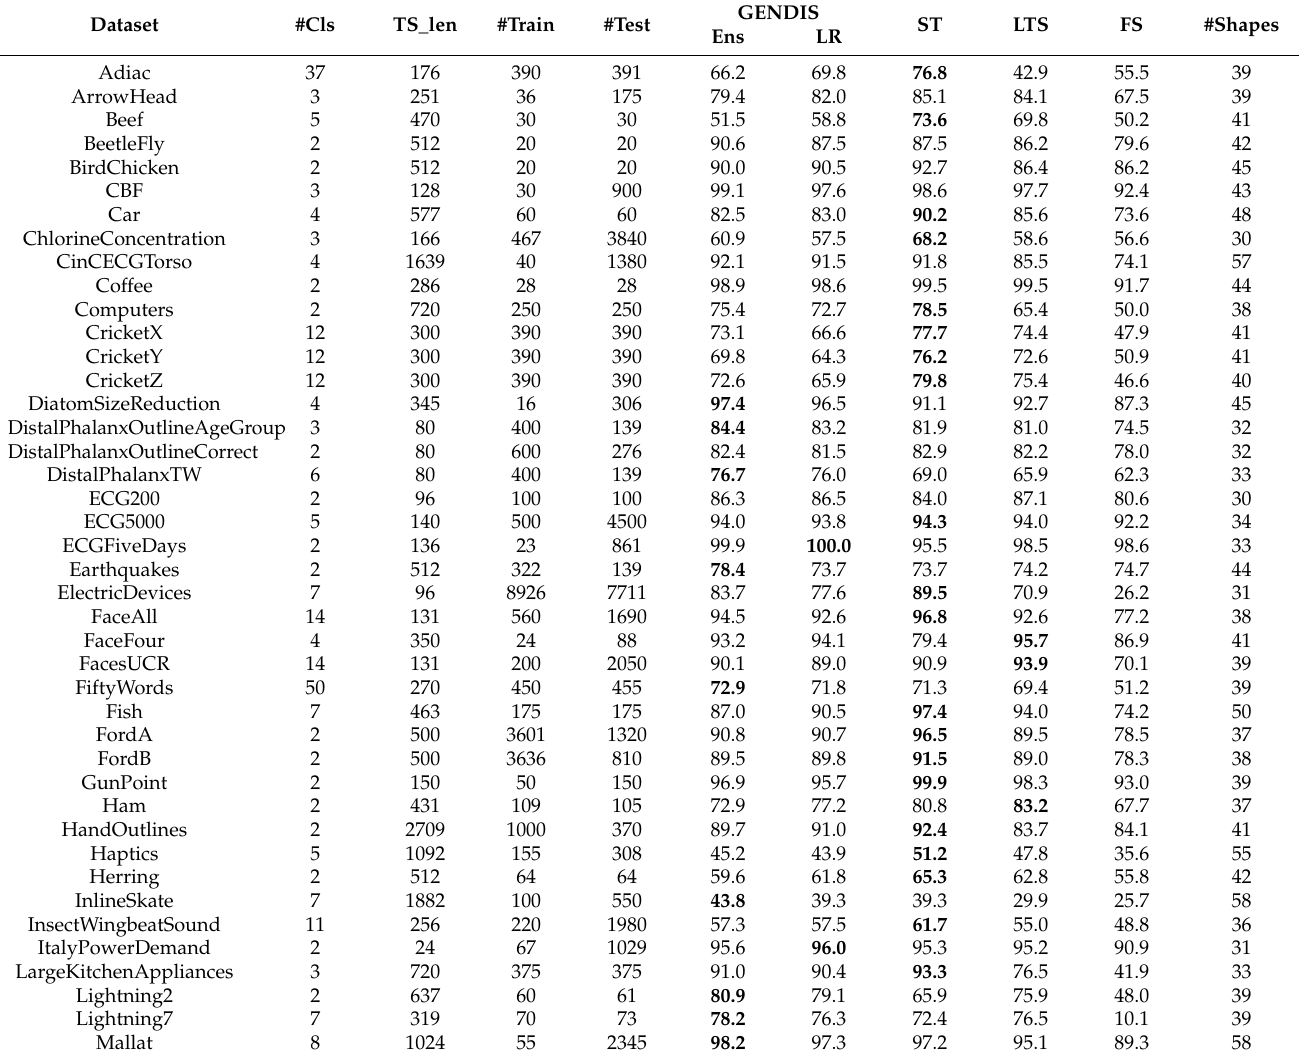
Table 2. A comparison between gendis and three other shapelet techniques on 85 datasets. ST, Shapelet Transform; LTS, Learning Time Series Shapelets; FS, Fast Shapelets; #Cls = number of Classes; TS_len = length of Time Series; #Train = number of Training time series; #Test = number of Testing time series; #Shapes = number of extracted shapelets by GENDIS.